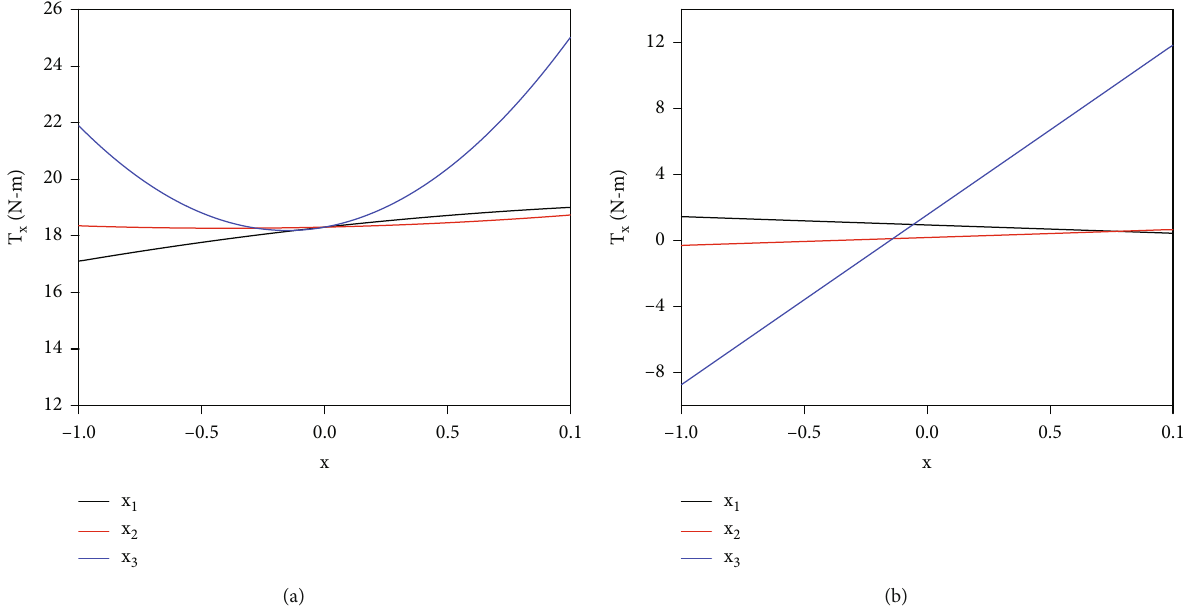
Figure 11: (a) Regression curves of the submodels and (b) the derivation curves of